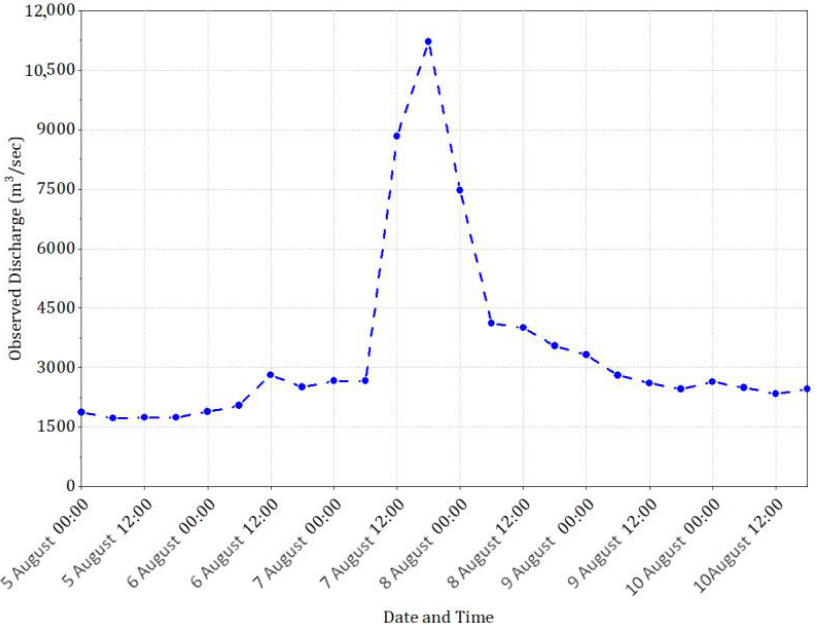
Figure 2. Six hourly observed flow rates (2016) at the Marala Barrage gauging site in Chenab River.